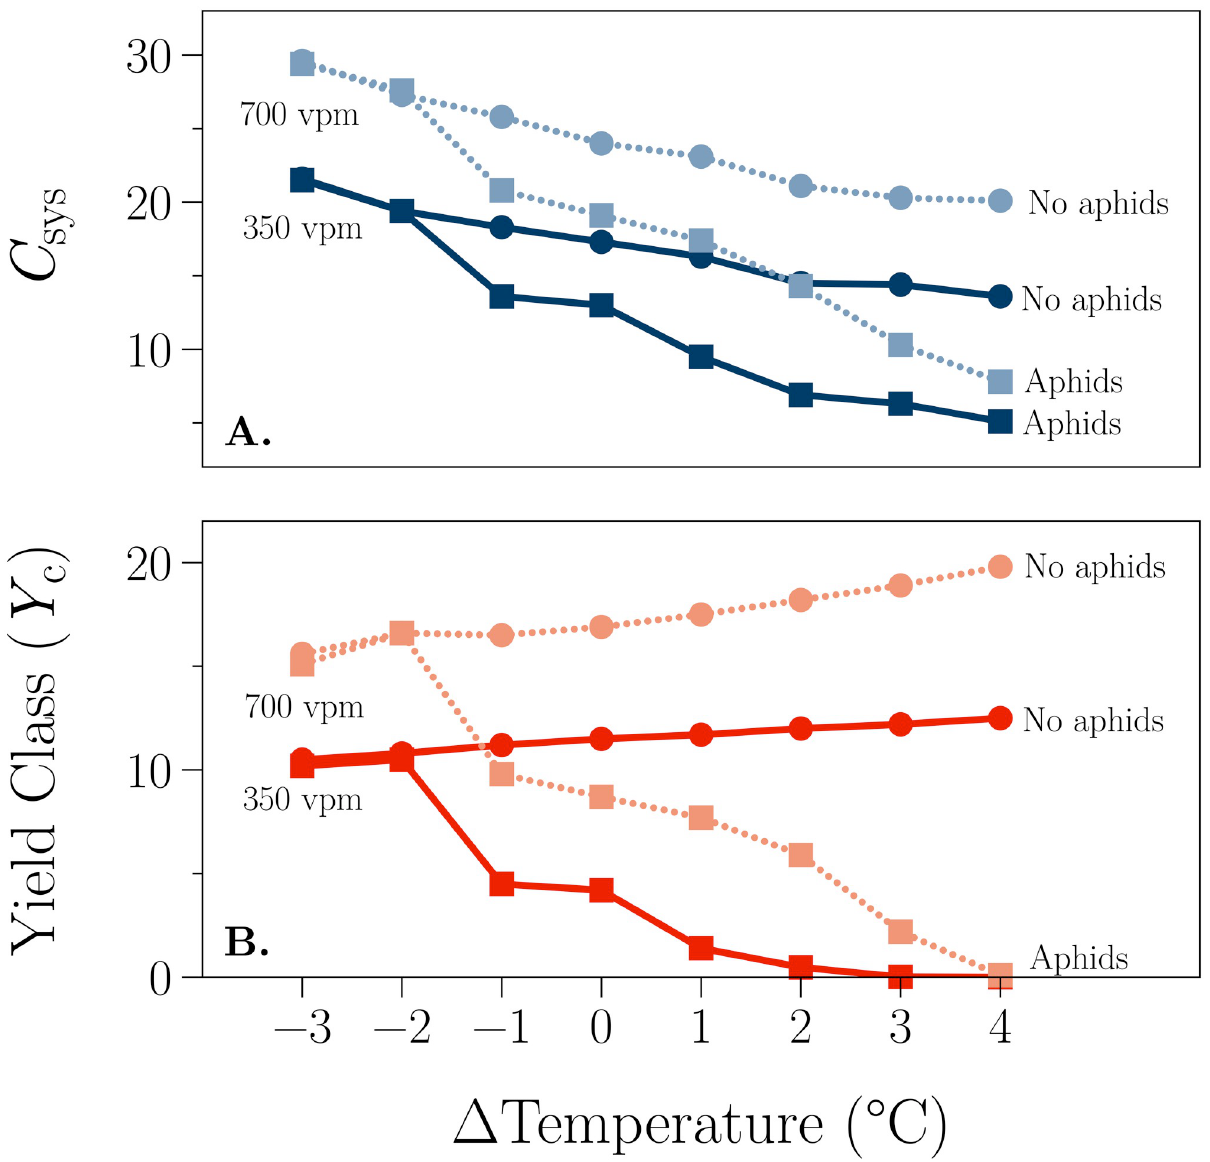
Fig 7. Yield and C-sequestration. Δ Temperature is the increment in air and soil temperatures applied to the Eskdalemuir environment (Section 4.1, Fig 3). The CO 2 concentration is denoted by the shading (dark color: 350 vpm, light color: 700 vpm). The aphid condition is denoted by the symbol ( ● : without aphids, ∎ : with aphids). Y C is the yield class (m 3 ha − 1 y − 1 ), defined as the volume (m 3 ) of timber harvested at the end of a rotation per hectare averaged over the duration of a rotation of 60 years; C sys (kg C m − 2 ) is the total C in the system at the end of the 60 y rotation. Results are shown for the no-aphid infestation situation (a steady state as applied in Fig 4) and for that when aphids are applied at time zero [Eq